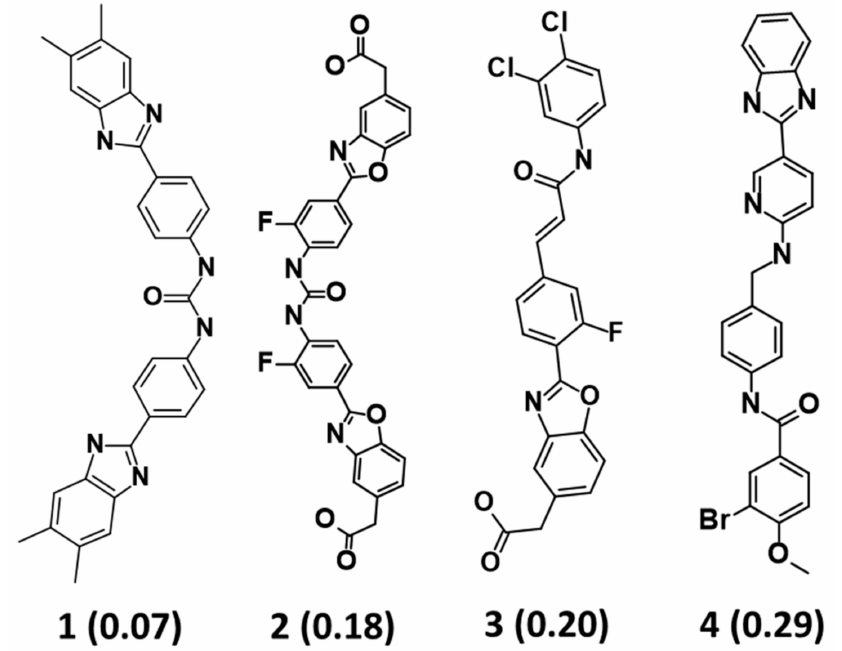
Figure 2. Two-dimensional (2D) structures of four active compounds used as training set for pharma- cophore hypotheses generation. The inhibitory activity value (IC 50 ) for each compound is shown in parentheses ( µ M). Table 1. Composition of the common-feature pharmacophore hypotheses generated by HipHop algorithm. Sr.